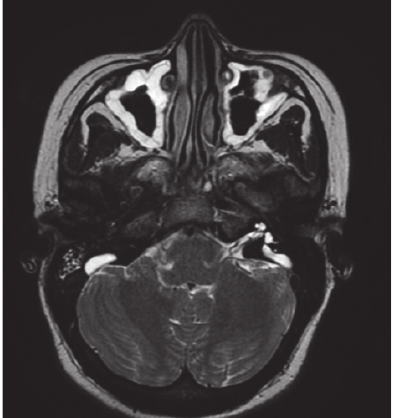
Figure 2: Magnetic resonance imaging of the inner ear showing the bilateral large vestibular aqueduct was